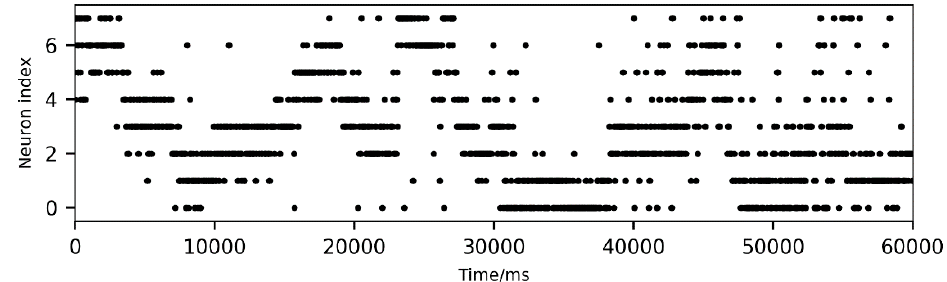
Figure 10. The spikes of the output layer of the SNN in one trial.